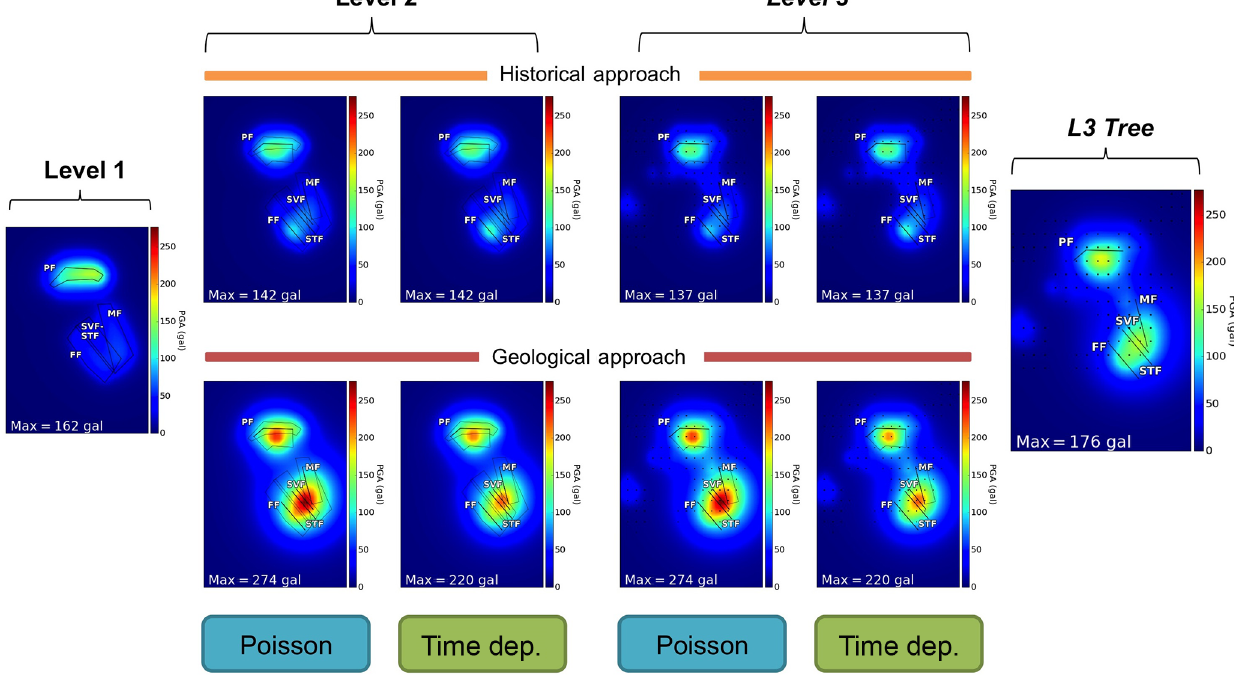
Figure 10. Hazard results for a 10% exceedance probability in 30 years in terms of PGA, when V s30 = 800ms − 1 . Thickest lines indicate fault